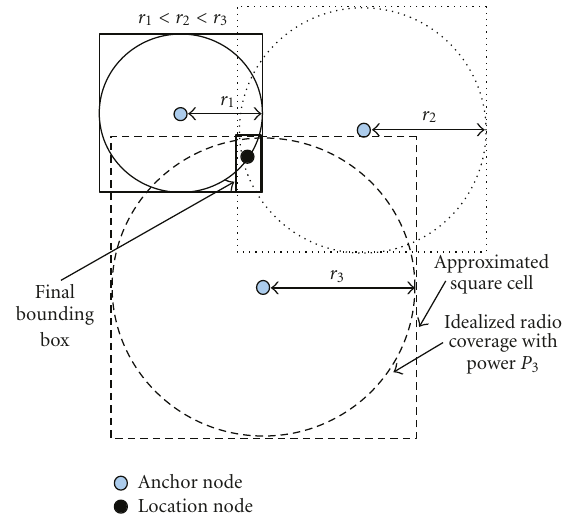
Figure 6: Localization cells and final bounding box.